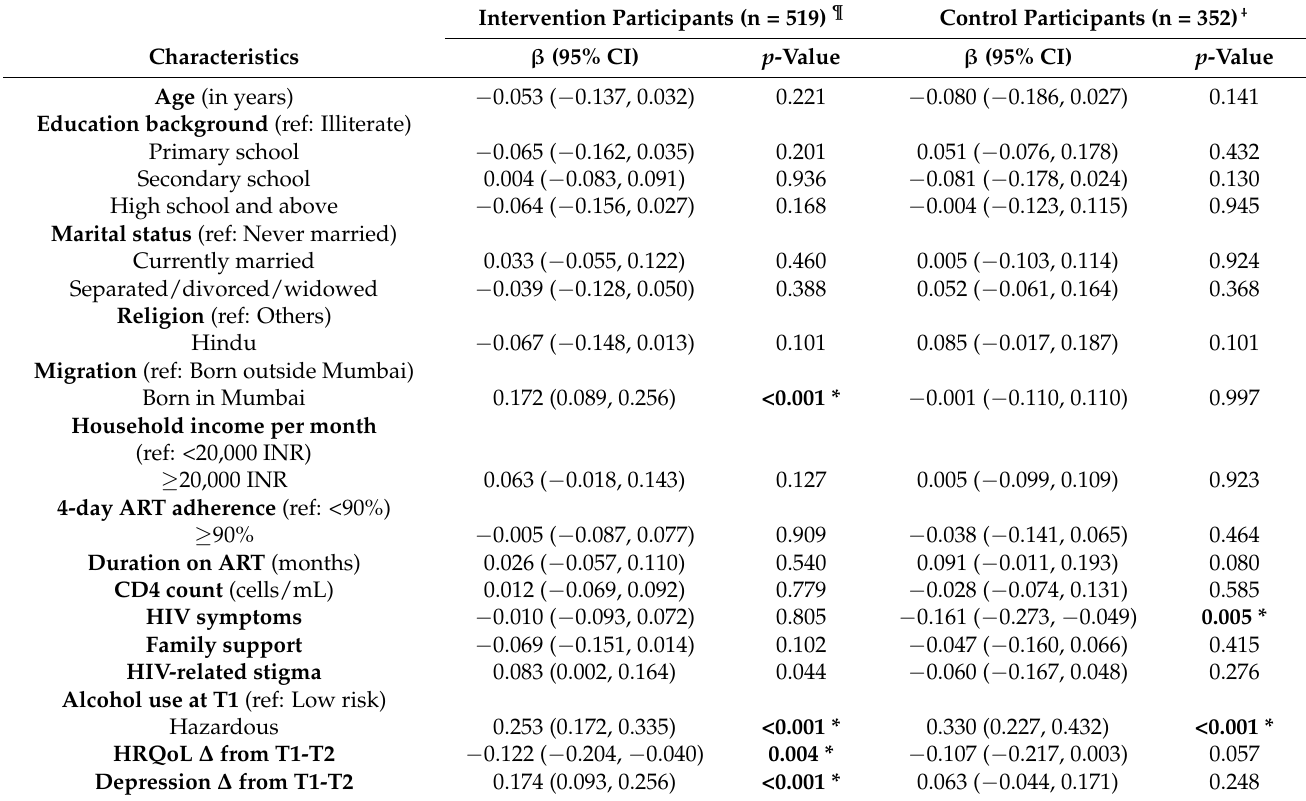
Table 4. Multiple linear regression of factors associated with alcohol use at